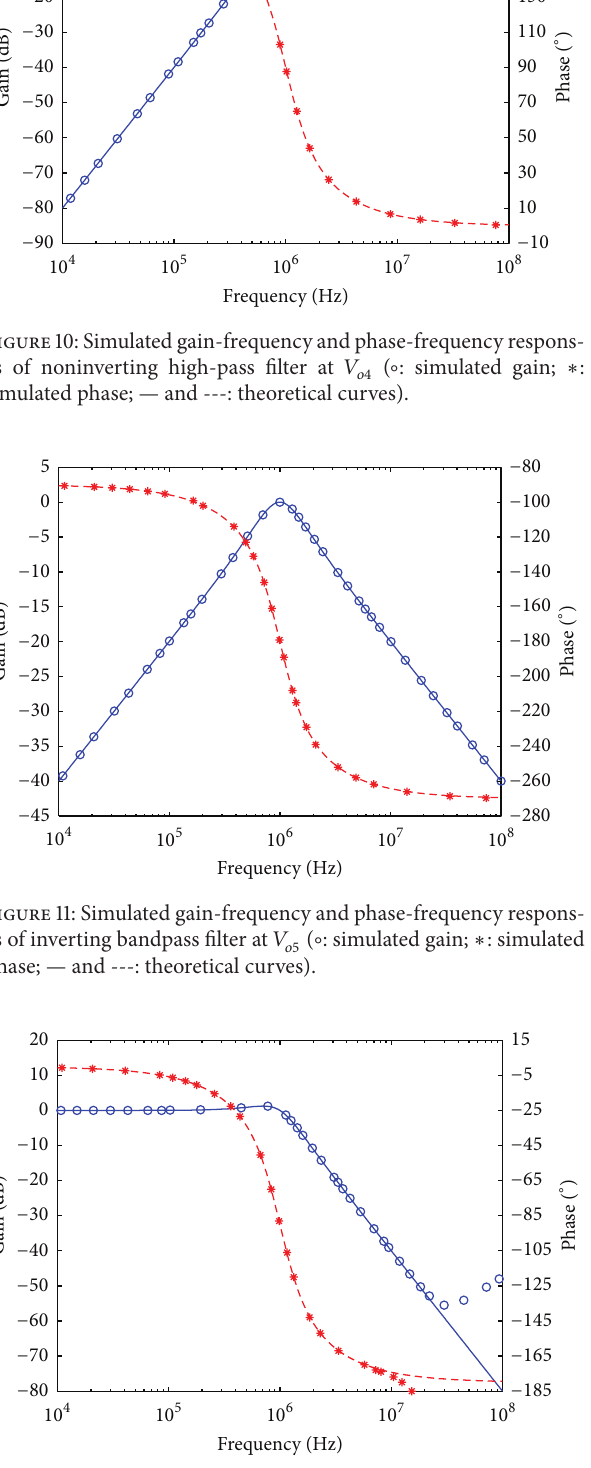
Figure 12: Simulated gain-frequency and phase-frequency respons- es of noninverting low-pass filter at 𝑉 𝑜6 ( ∘ : simulated gain; ∗ : simulated phase; — and ---: theoretical curves).